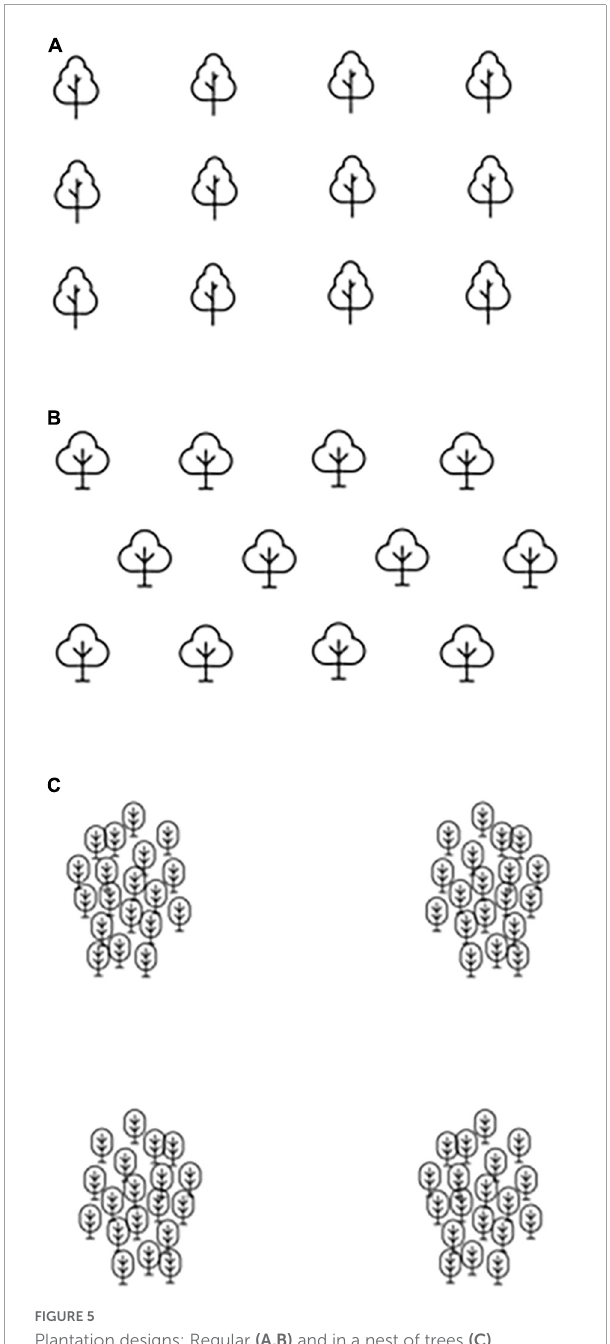
FIGURE5 Plantation designs: Regular (A,B) and in a nest of trees (C)